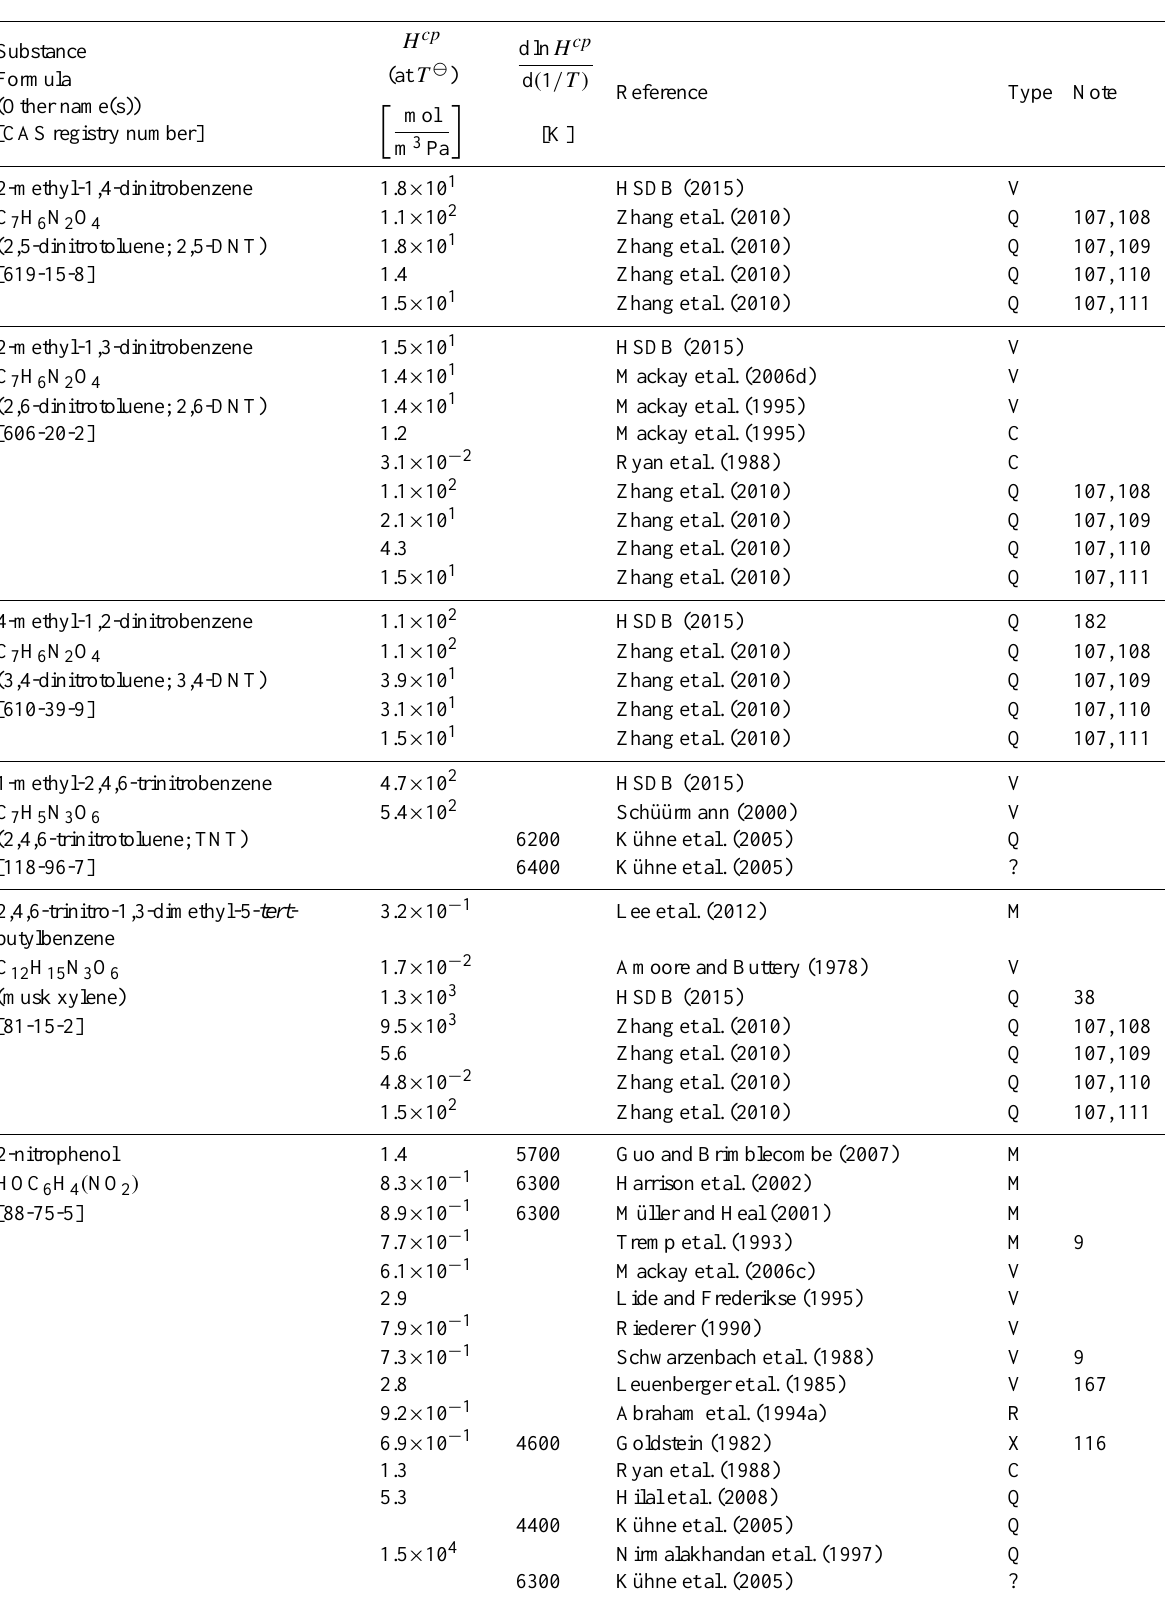
Table 6: Henry’s law constants for water as solvent